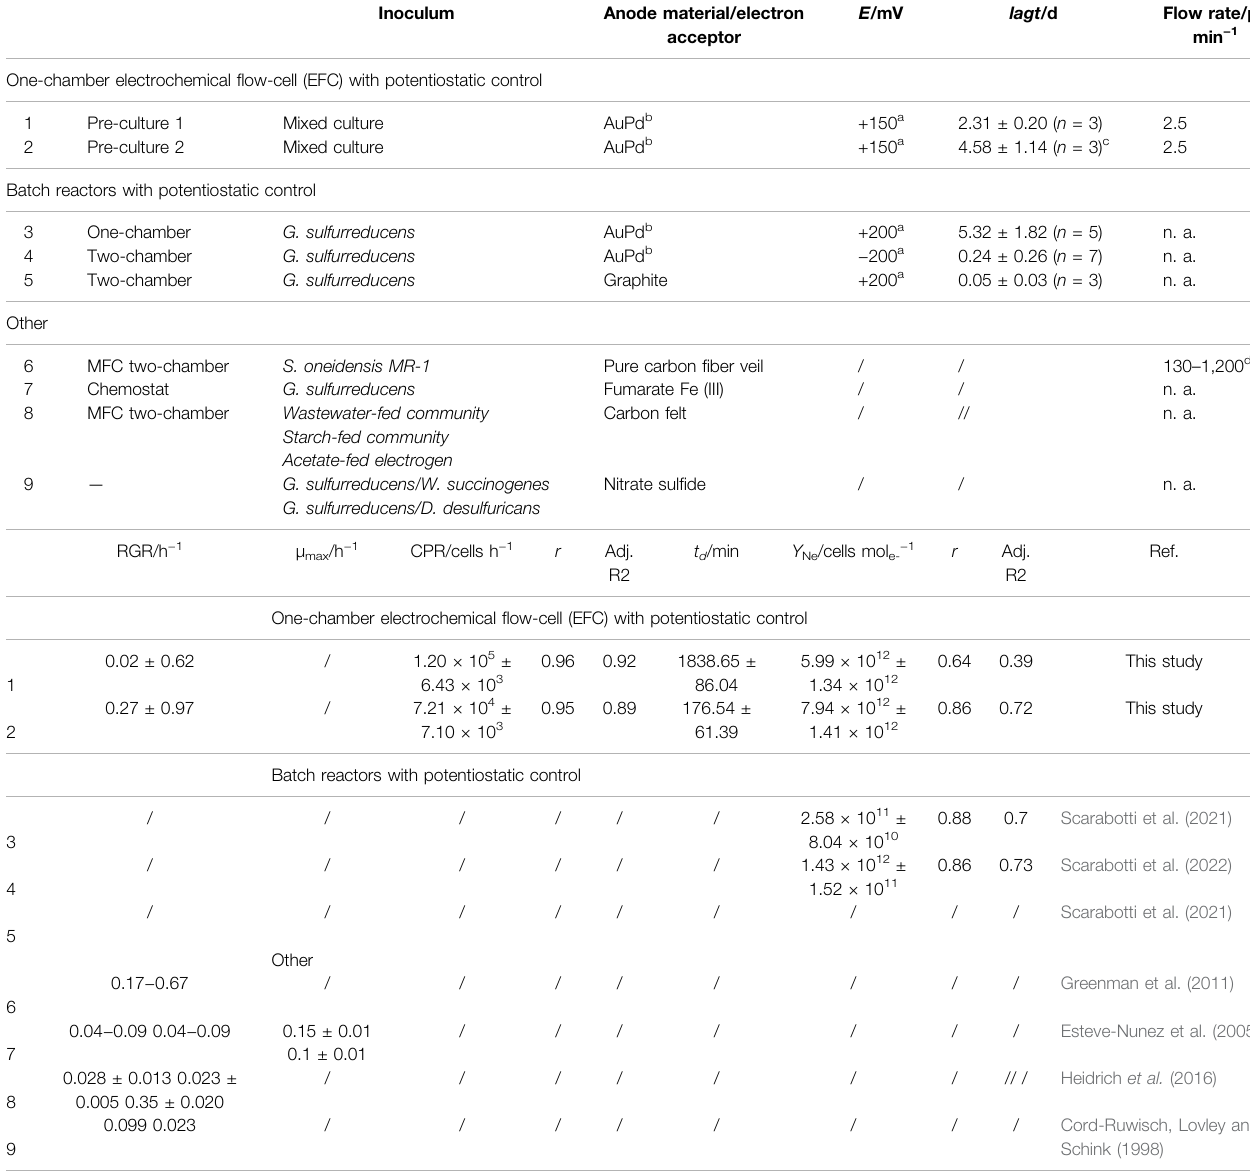
TABLE1| Latencytime( lagt ),relativegrowthrates(RGR),cellproductionrate(CPR),doublingtimes( t d ),andyieldcoef fi cients( Y Ne )ofearly-stagemixedcultureelectroactive bio fi lms. Inoculum Anode material/electron acceptor One-chamber electrochemical fl ow-cell (EFC) with potentiostatic